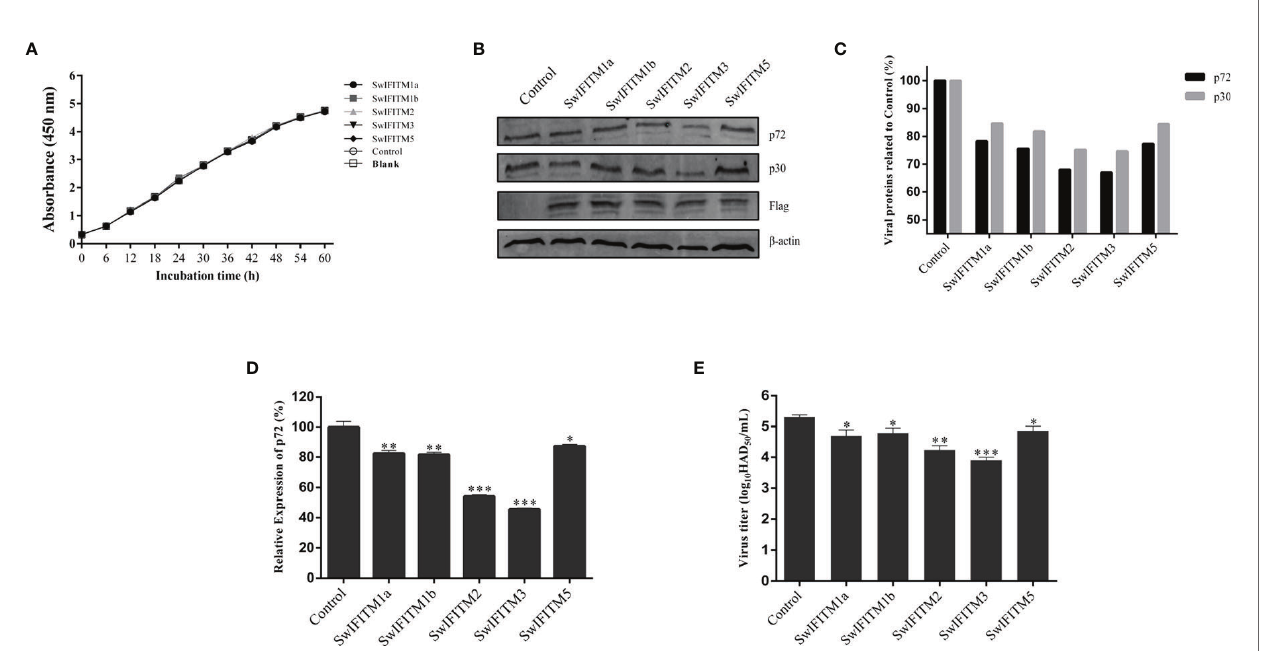
FIGURE 6 | Antiviral effect of SwIFITMs on ASFV. pEF-SwIFITMs with FLAG stag were transfected into csIFITMs − Vero cells separately for 24 h and then infected with 0.1 MOI of ASFV; (A) the cells viability was detected by cell proliferation assay; (B, C) the virus replication levels of ASFV were determined by western blotting at 36 hpi, and band densitometry for each protein was determined, and the density quantitative ratios of each viral or SwIFITM protein and b -actin were calculated, ratio of SwIFITM protein and b -actin served as a control; (D) the expression levels of p72 protein were detected by RT-qPCR with b -actin used as a control at 36 hpi; (E) the viral titration of progeny virus was tested in HAD assay. Samples were analyzed in triplicate, and three independent experiments were performed. * p < 0.05; ** p < 0.01; *** p <0.001 vs empty vector control group. Error bars indicate standard